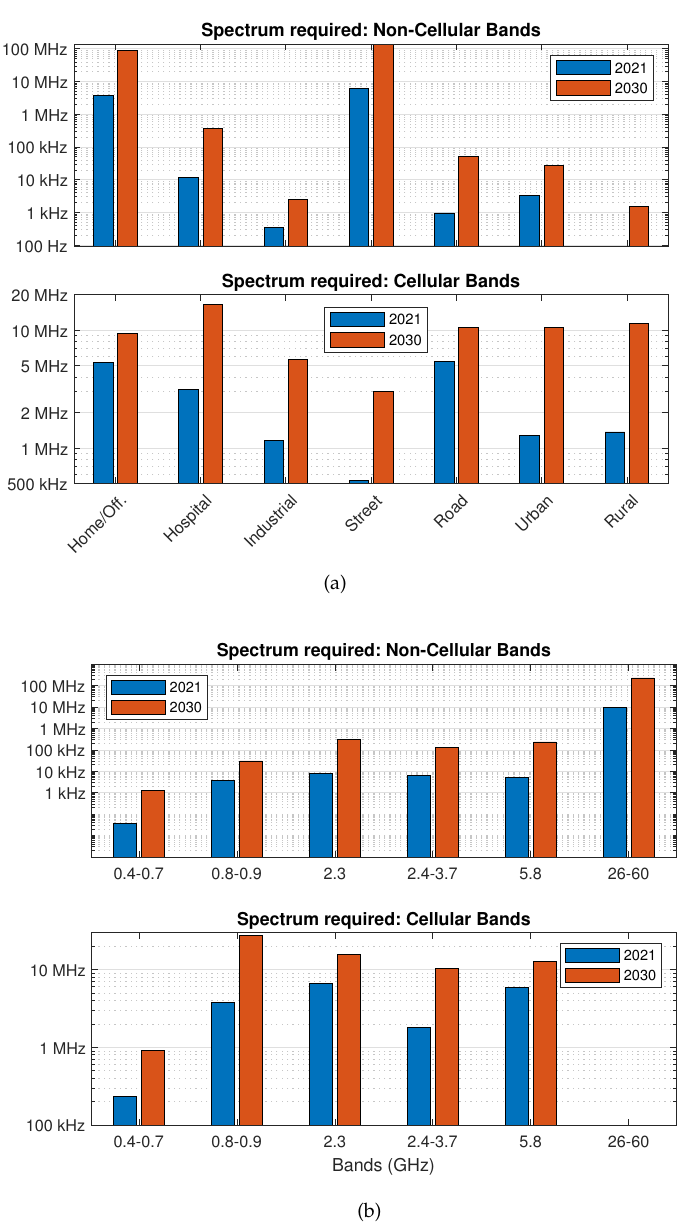
Figure 5. Cellular and non-cellular spectrum requirement increase from 2021 to 2030: ( a ) per coverage area and ( b ) per frequency